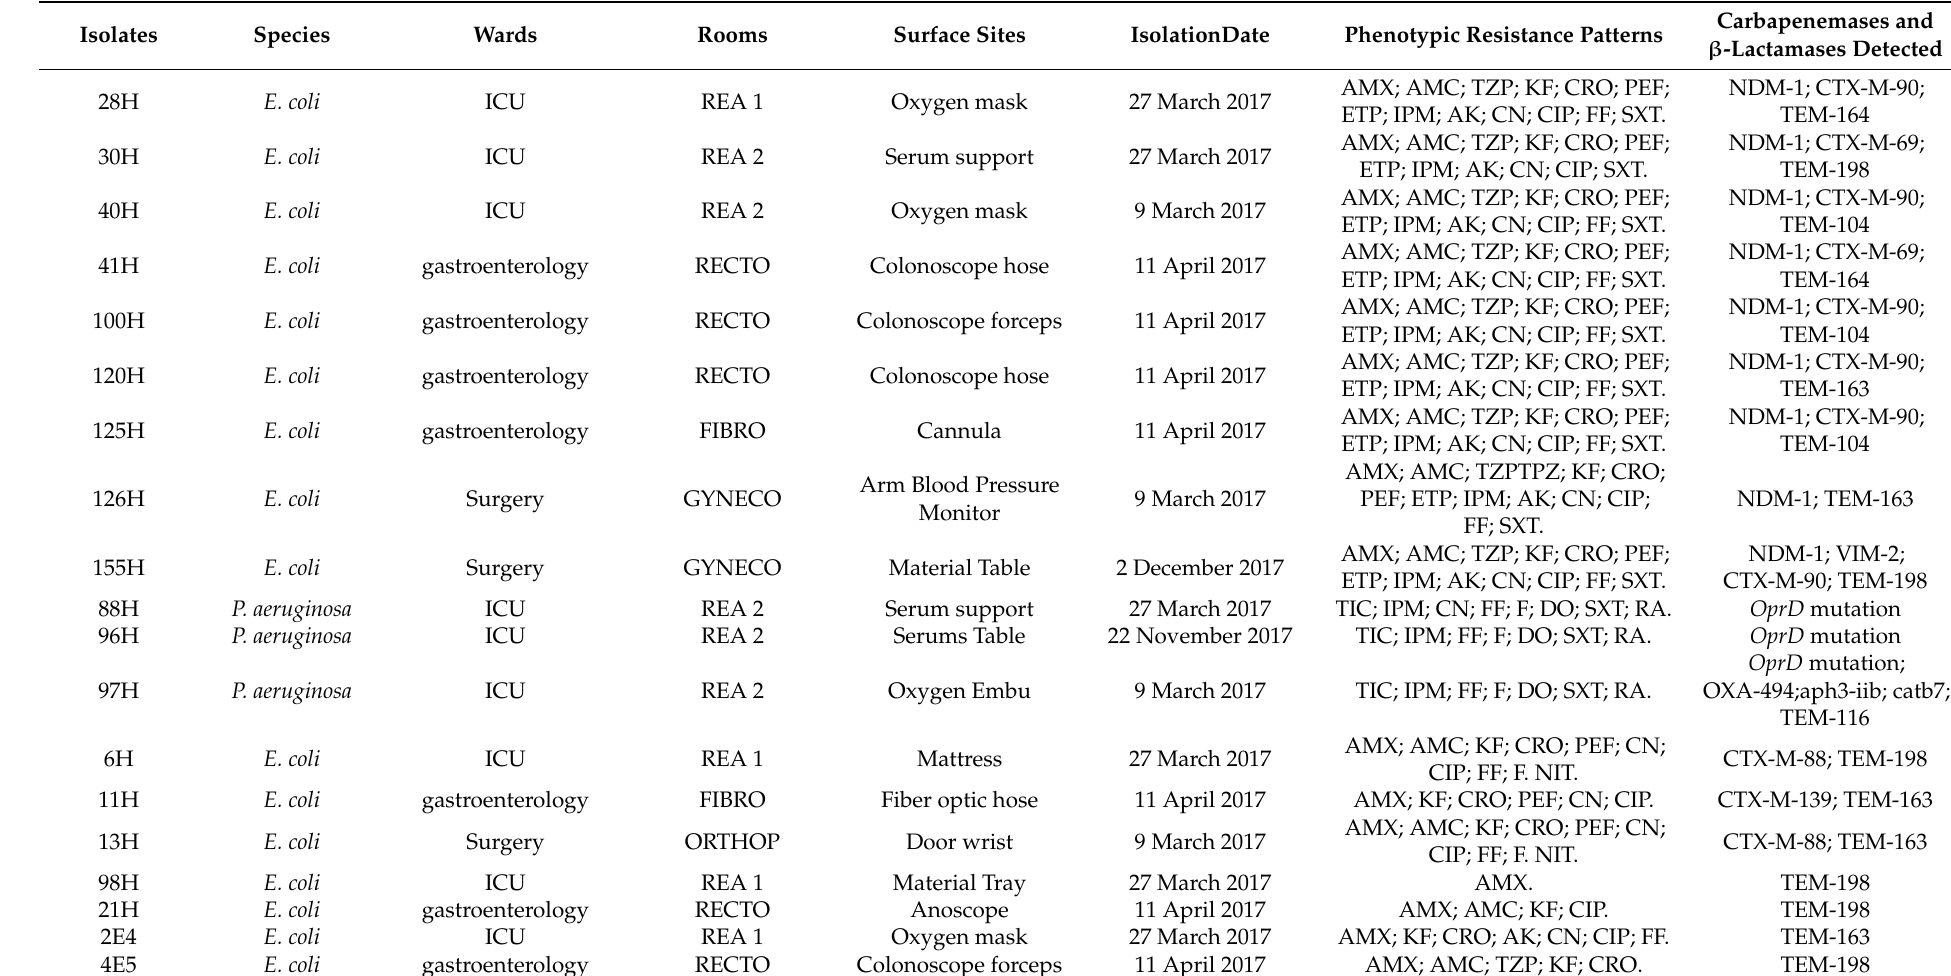
Table 4. Phenotypic and molecular characterization of MBL and ESBL producers isolated from hospital